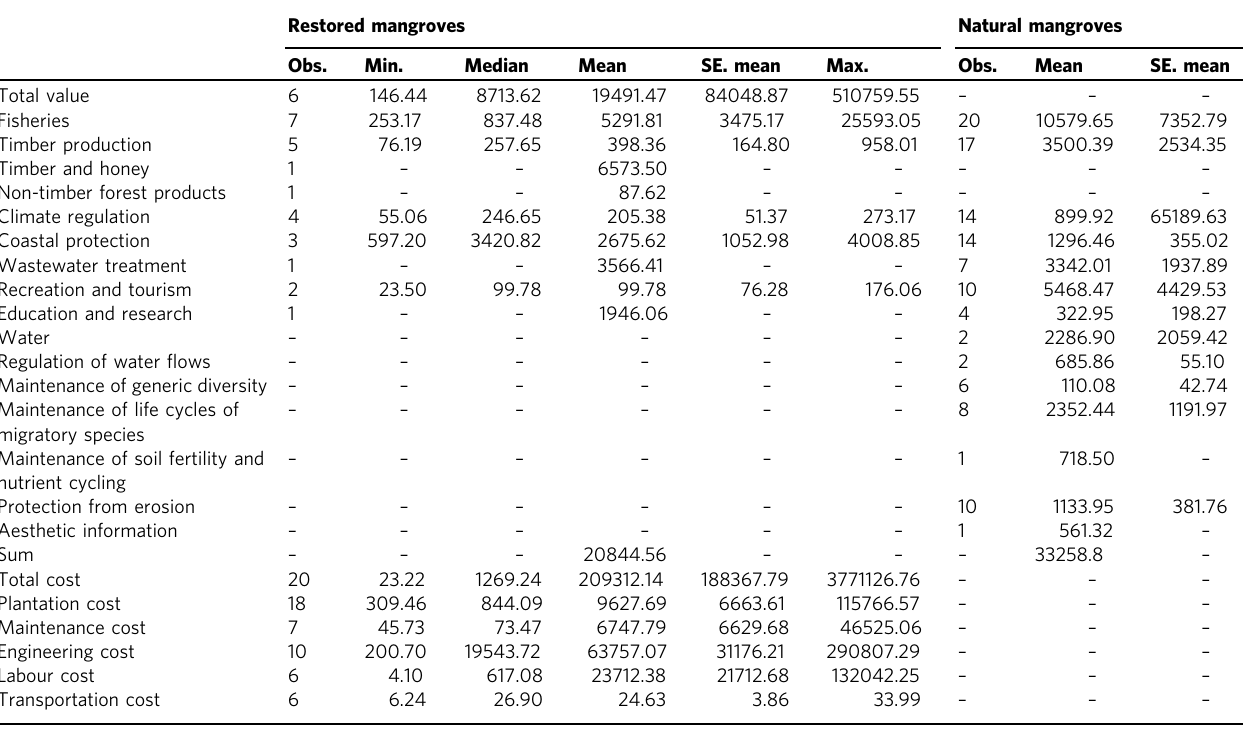
Table 1 Economic bene fi ts (in 2019 USD ha − 1 yr − 1 ) and costs (in 2019 USD ha − 1 ) from mangrove